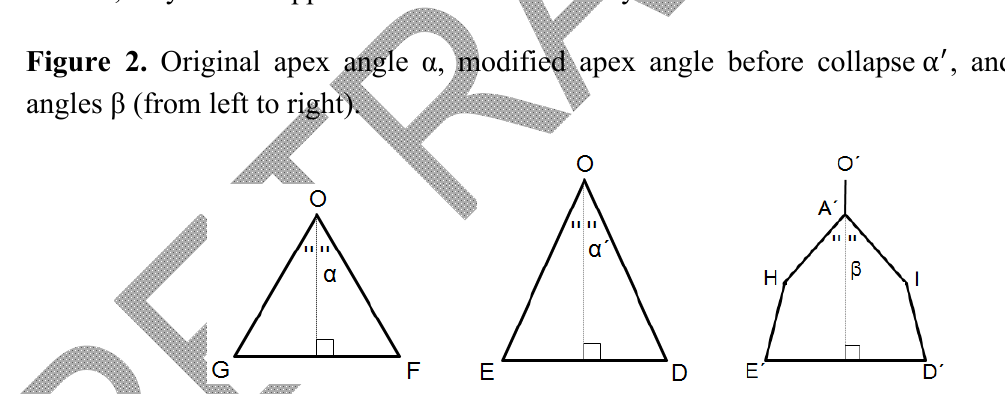
Figure 2. Original apex angle α , modified apex angle before collapse α (cid:4593) , and collapse angles β (from left to right).